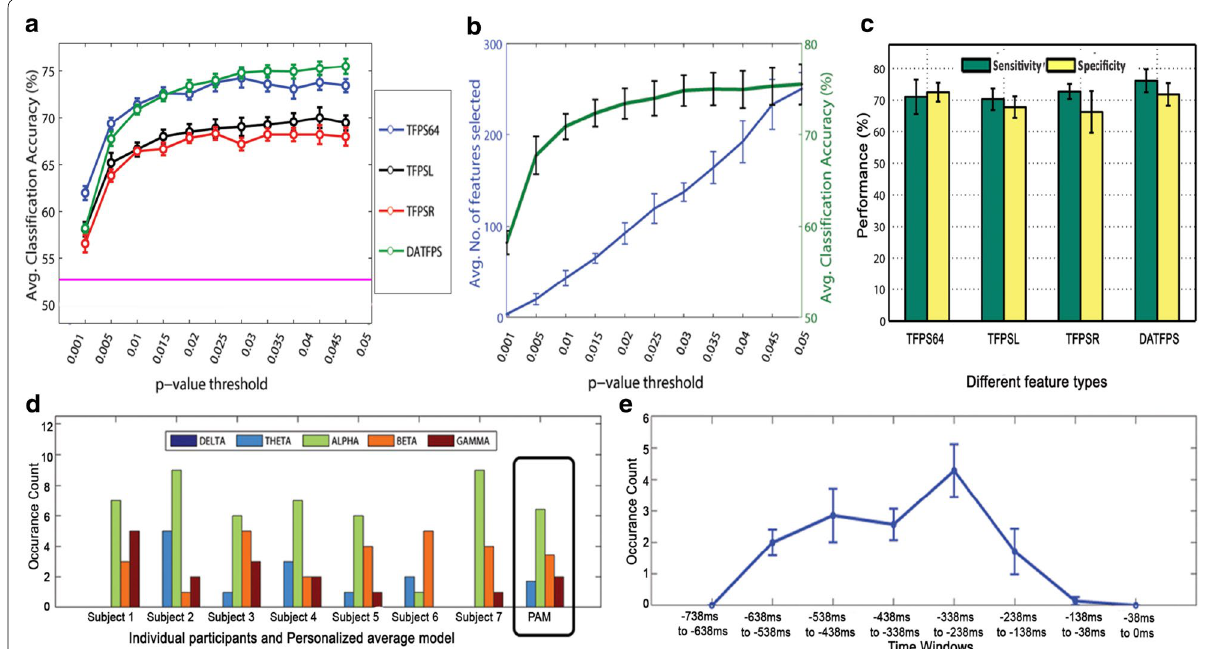
Fig. 5 Results of subject-wise analysis: a Classification performance of different features with respect to different p value thresholds that used in feature selection method. Average classification accuracy of time–frequency power spectrum features of all 64 electrodes (TFPS64), left hemispheric electrodes (TFPSL), right hemispheric electrodes (TFPSR) and differential asymmetry between hemispheric features (DATFPS) are represented along with empirical chance level (pink horizontal line). Error bars indicate standard error of mean (SEM). b Representation of number of selected features and average classification accuracy of DATFPS feature with respect to different p value thresholds as DATFPS feature set yielded the best performance for all subjects. c Sensitivity and specificity performance (in %) for each feature type. Error bars indicate standard deviation (SE) across subjects. d Representation of occurrence count of dominant features. Band-wise dominant features for each subject is shown for DATFPS feature type. Among five EEG frequency bands, maximum selected features belonged from alpha frequency band. e Temporal course of occurrence count of dominant features. Error bars indicate SEM across subjects